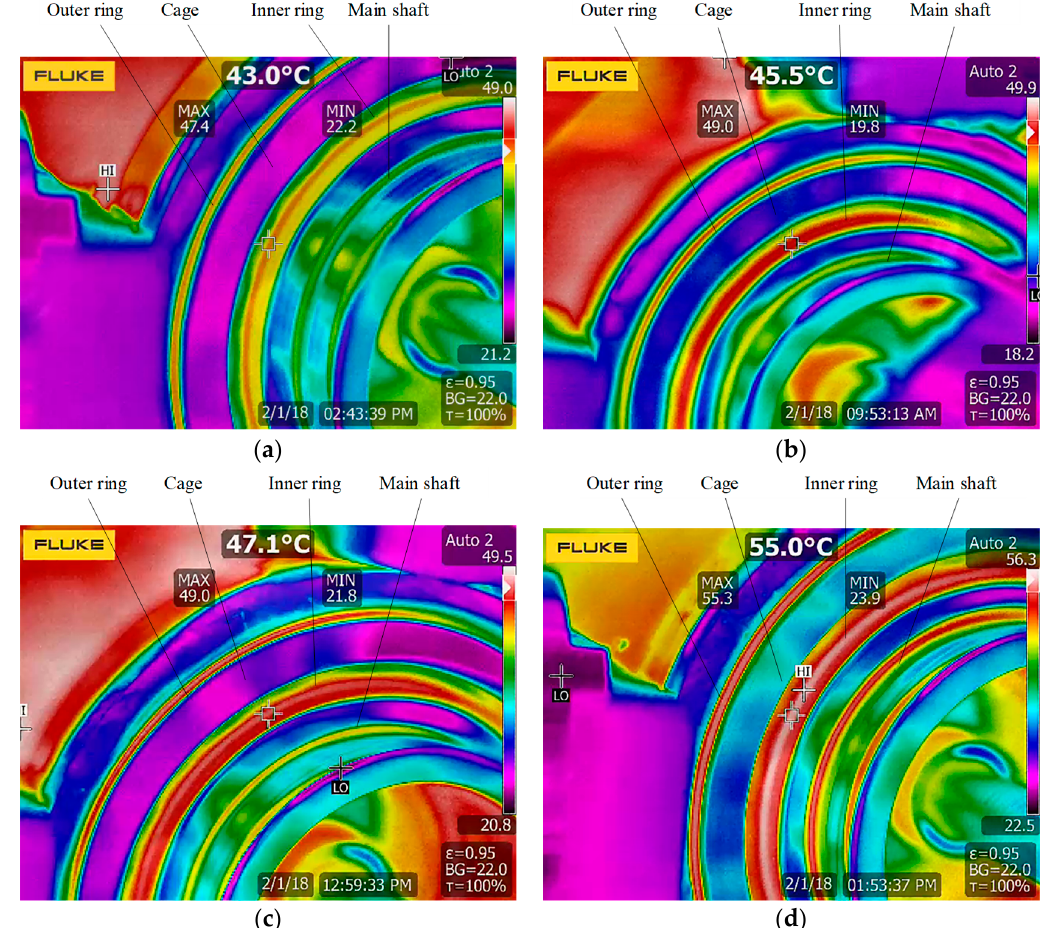
Figure 14. Temperature distribution diagram of the bearing: ( a ) radial load: 400 N; inner ring speed: 1200 r/min; kinematic viscosity: 15 cSt; ( b ) radial load: 400 N; inner ring speed: 1800 r/min; kinematic viscosity: 15 cSt; ( c ) radial load: 600 N; inner ring speed: 1800 r/min; kinematic viscosity: 32 cSt; and ( d ) radial load: 600 N; inner ring speed: 1200 r/min; kinematic viscosity: 46 cSt.